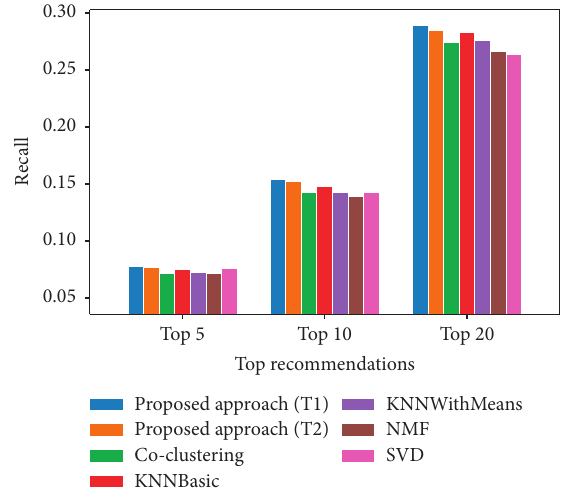
Figure 5: Recall at ( k ) where k � 5, 10 and 20.